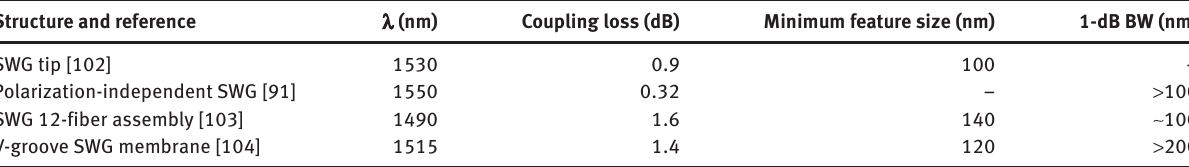
Table 7: Experimental results for subwavelength structured fiber-to-chip edge couplers. Structure and reference